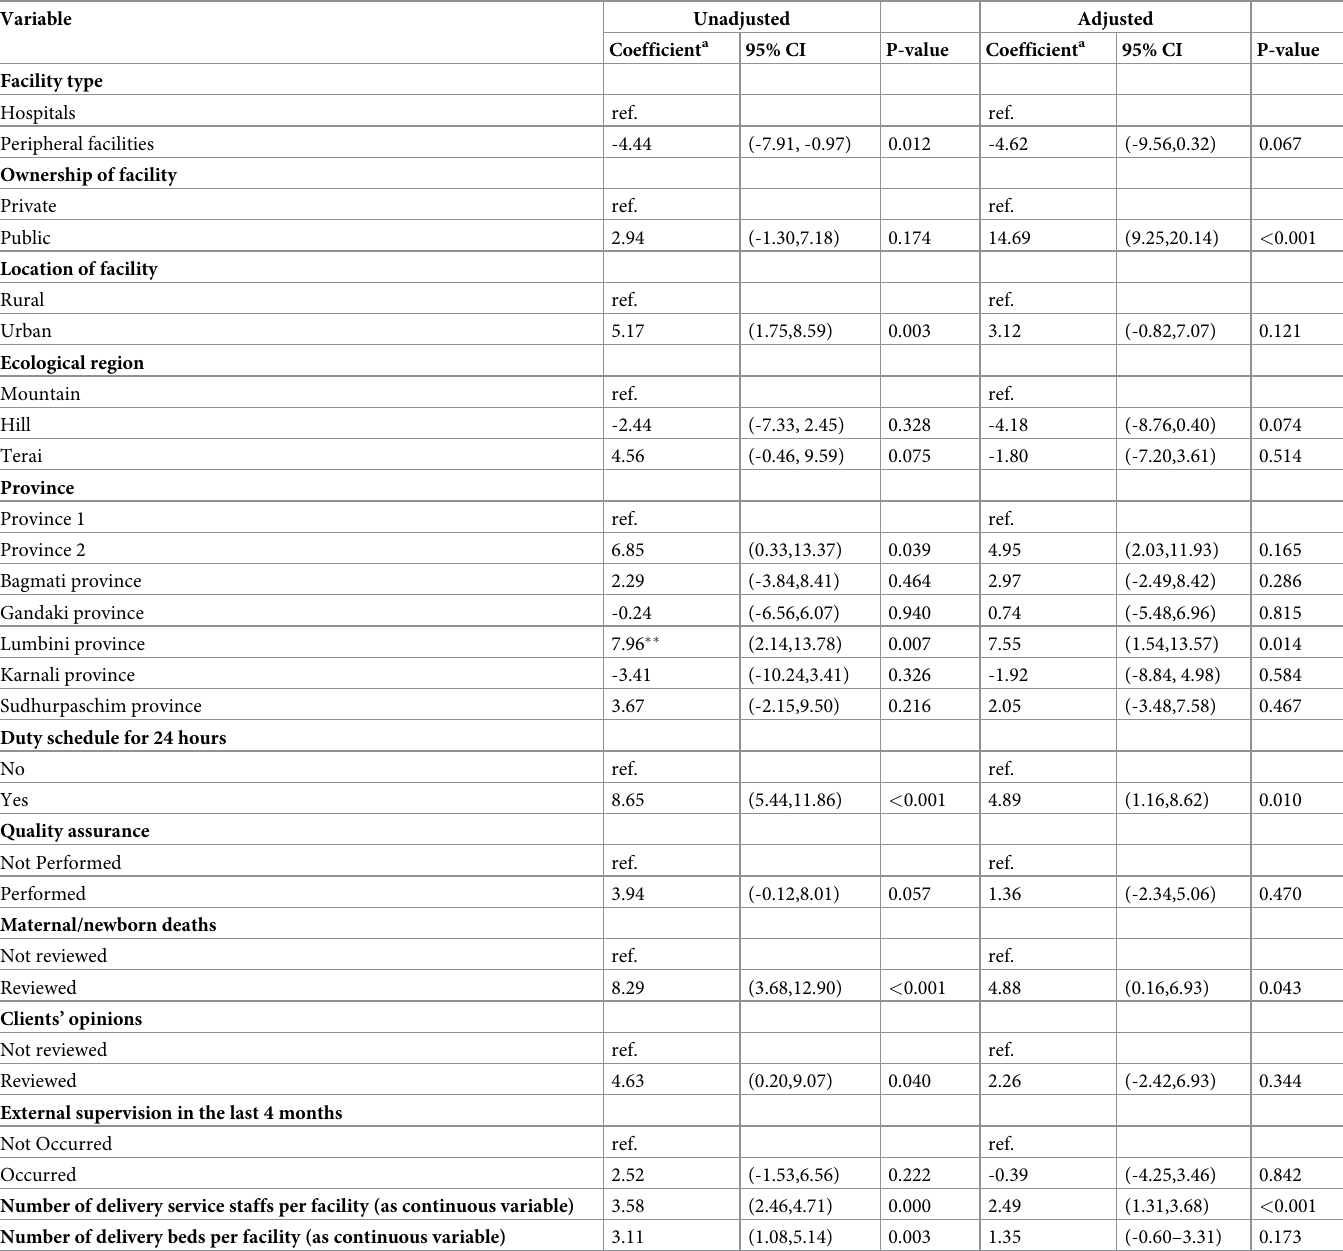
Table 4. Factors associated with BEmONC services readiness (n =